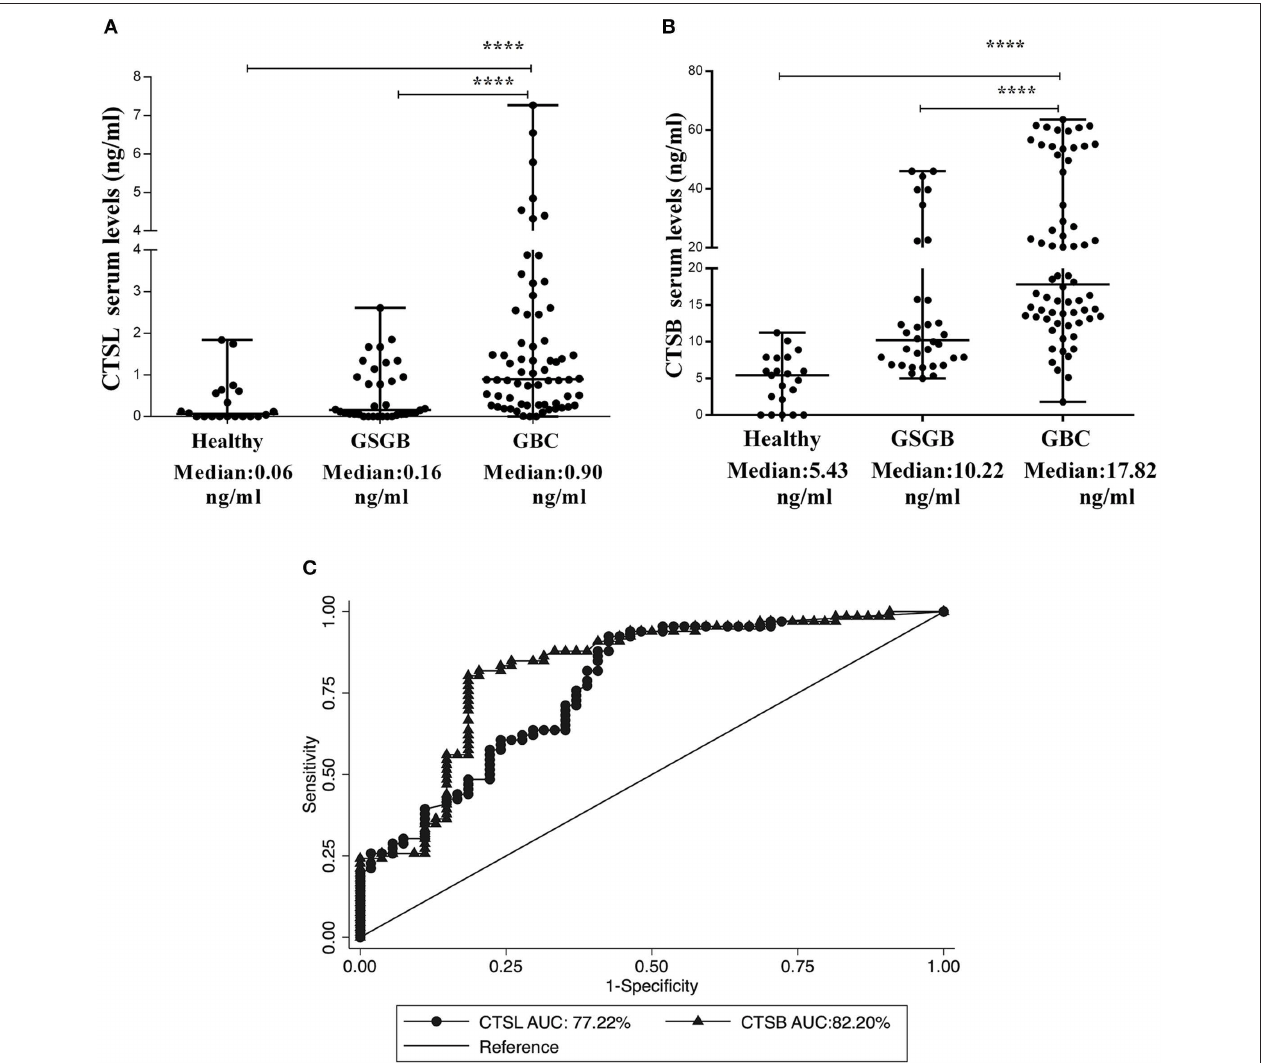
FIGURE 6 | Elevation in serum levels of CTSL and CTSB in GBC patients. Dot plot representation of (A) CTSL and (B) CTSB and in the serum of healthy individuals ( n = 20), GSGB ( n = 34), and GBC patients ( n = 66) as estimated by ELISA. Serum levels of CTSL and CTSB were significantly higher in GBC patients as compared to both healthy individuals and patients with gallstone disease. Median serum values have been represented by the horizontal bar in the middle. Results were analyzed by the Mann-Whitney U test, and values significantly different from both GS and healthy controls have been marked by **** p < 0.0001. (C) ROC curve analysis of serum cysteine cathepsins showing excellent diagnostic performance of both CTSL (AUC − 77%) and CTSB (AUC − 82%) in distinguishing GBC patients from control subjects.